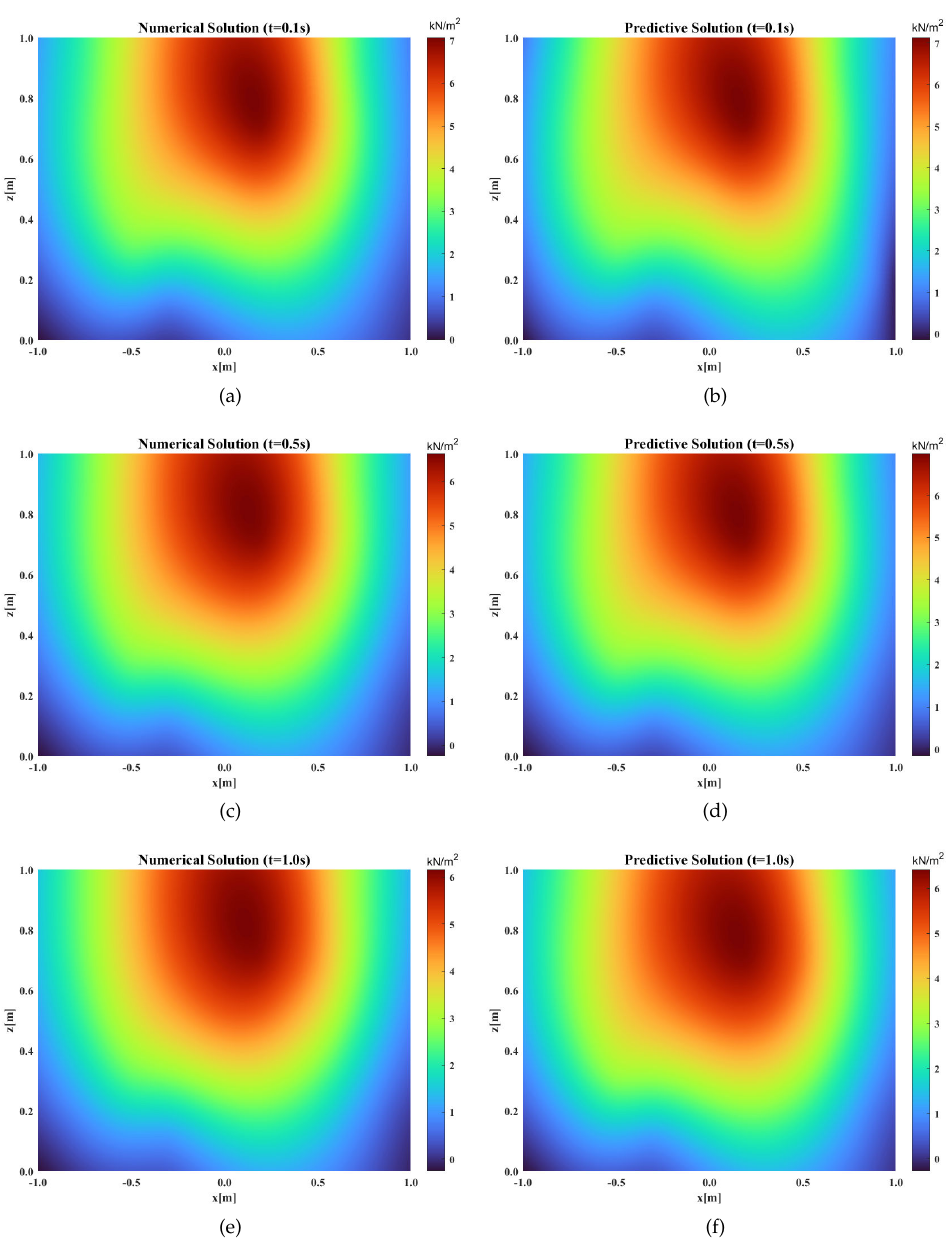
Figure 6. Color maps for numerical solution and predicted solution of two-dimensional soil consolida- tion for drainage at a top boundary at different times. ( a ) Numerical solution (t = 0.1 s); ( b ) Predictive solution (t = 0.1 s); ( c ) Numerical solution (t = 0.5 s); ( d ) Predictive solution (t = 0.5 s); ( e ) Numerical solution (t = 1.0 s); ( f ) Predictive solution (t = 1.0